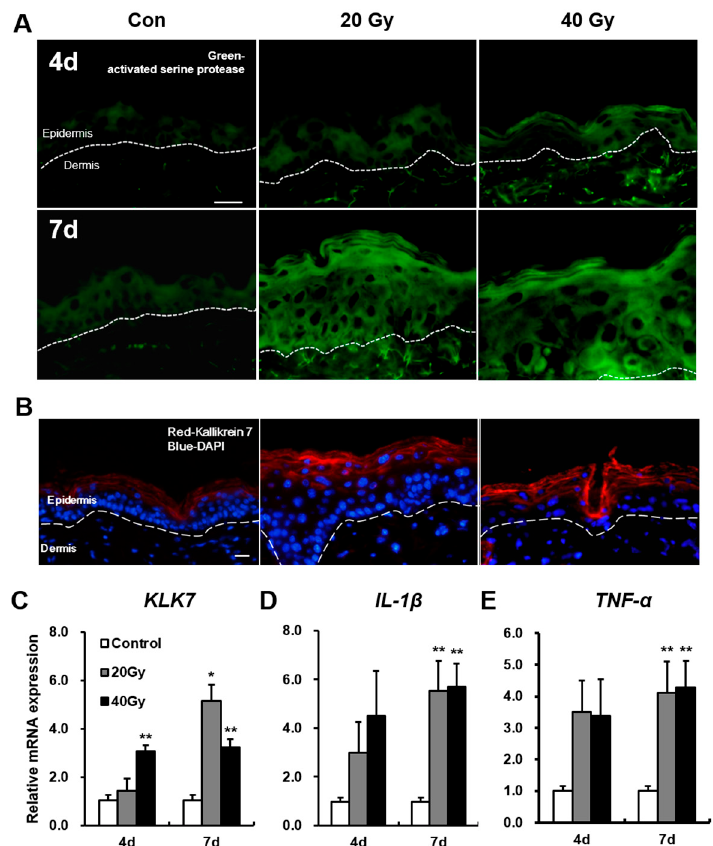
Figure 5. Upregulation of serine protease (KLK7) activity and expression in the latent stage of the irradiated skin. ( A ) Assay of serine protease activity by in situ zymography in the skin of 0 (control; Con), 20, and 40 Gy irradiation at 4 and 7 days. Scale bar = 20 µ m; ( B ) Immunofluorescence stain of KLK 7 in the irradiated skin of 0 (control; Con), 20, and 40 Gy at 7 days. Bar = 20 µ m. mRNA levels of ( C ) KLK7 ; ( D ) IL-1 β , and ( E ) TNF- α in the irradiated skin of 0 (control), 20, and 40 Gy at 4 and 7 days. Data are presented as the mean ± standard error of the mean. n = 5 mice for each group. * p < 0.05 and ** p < 0.01 compared with the control group.